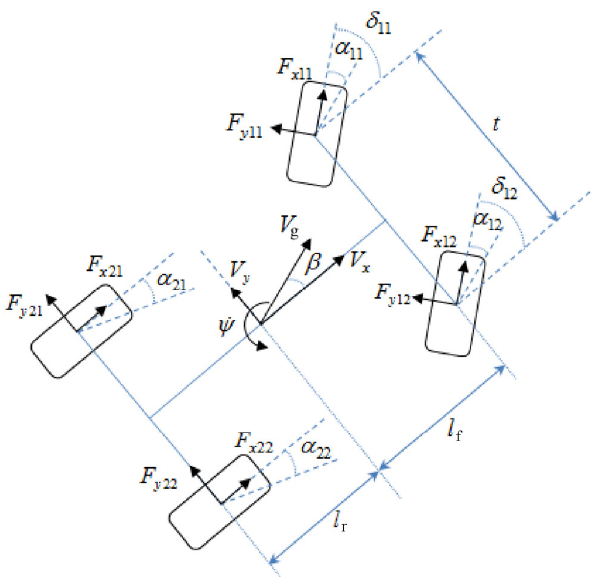
Fig. 10 The schematic of four wheel vehicle